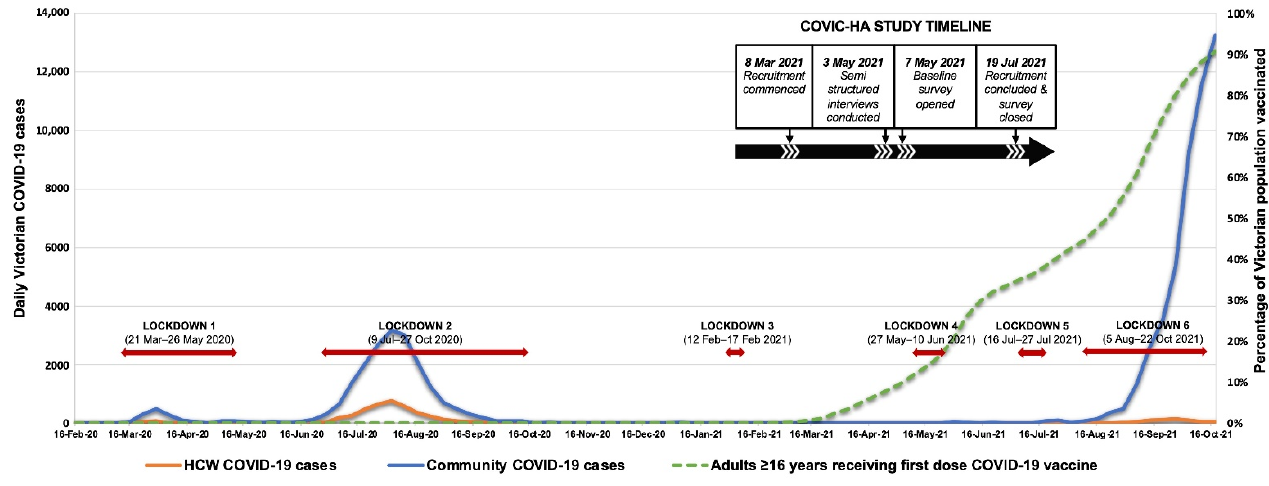
Figure 1. COVID-19 case numbers sourced from Victorian COVID-19 data available at https://www.coronavirus.vic.gov.au/victorian-coronavirus-covid-19-data (accessed on 18 November 2021); Victorian healthcare worker (clinical and non-clinical) COVID-19 data available at https://www.coronavirus.vic.gov.au/healthcare-worker-covid-19-data (accessed on 18 November 2021). COVID-19 vaccine data for Victoria were sourced from https://www.coronavirus.vic.gov.au/weekly-covid-19-vaccine-data#covid-19-vaccine-rates-for- second-dose-by-postcode (accessed on 18 November 2021).